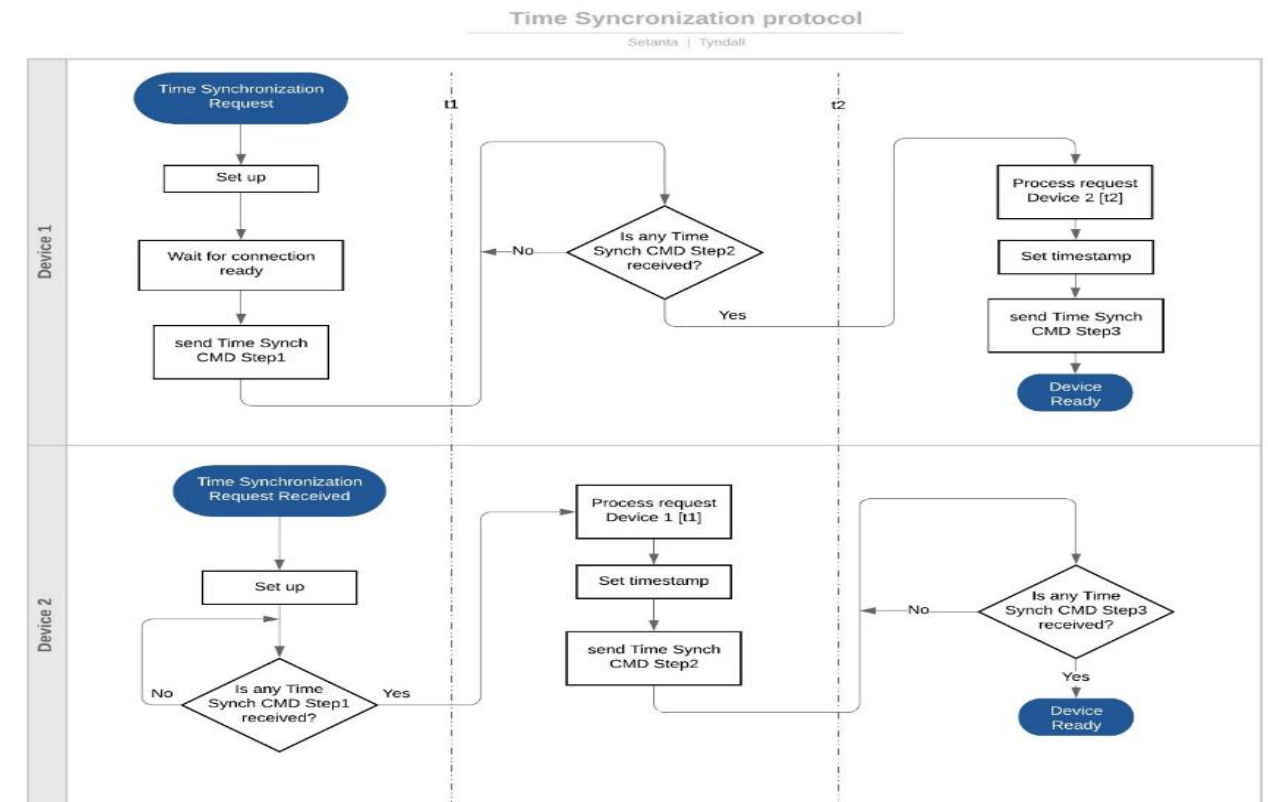
Figure 6. Time synchronization process.